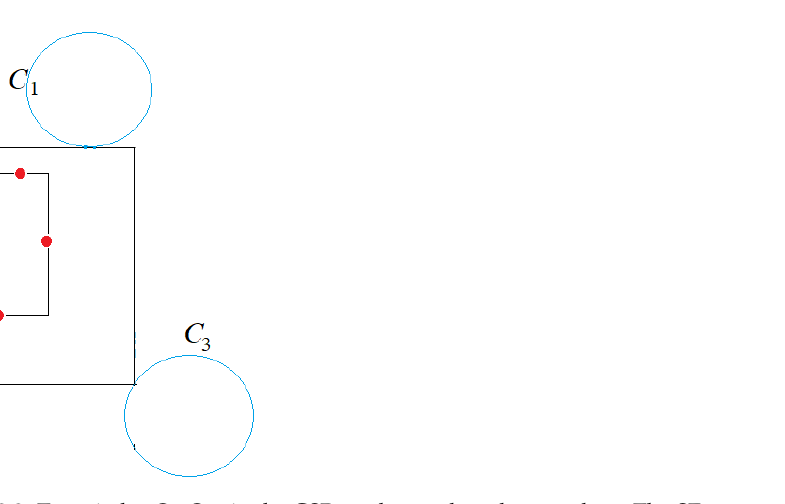
Figure 15. Case 2.2: Two circles C 1 , C 2 pin the CSR on the north and west edges. The SE corner may slide along a circle C 3 .